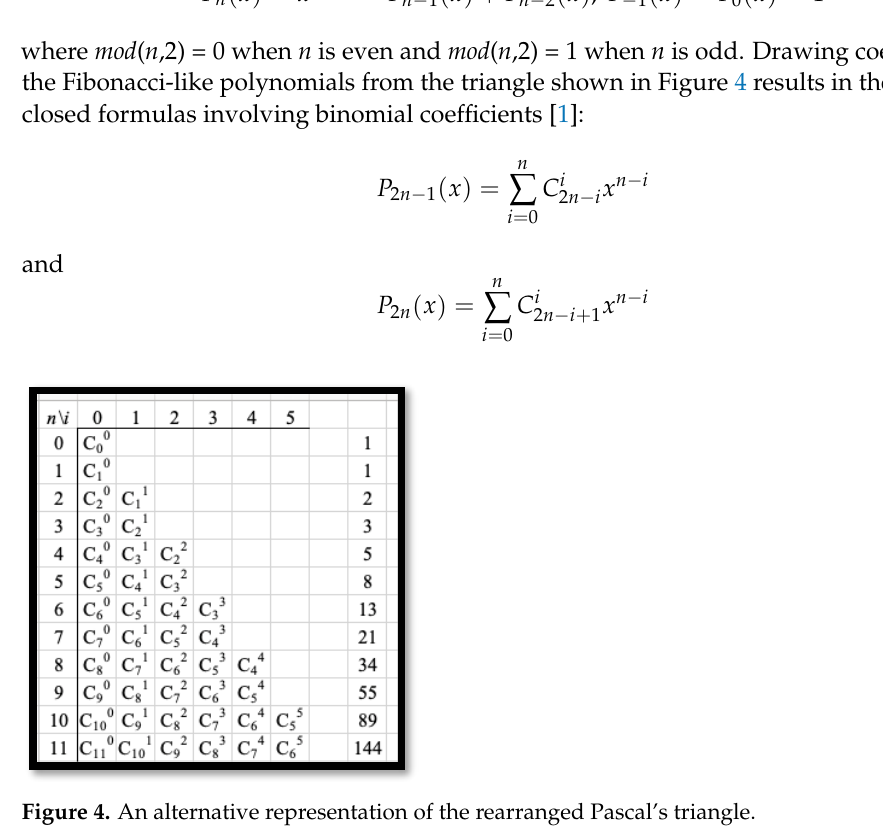
Figure 2. Rearranged Pascal’s triangle and Fibonacci numbers.